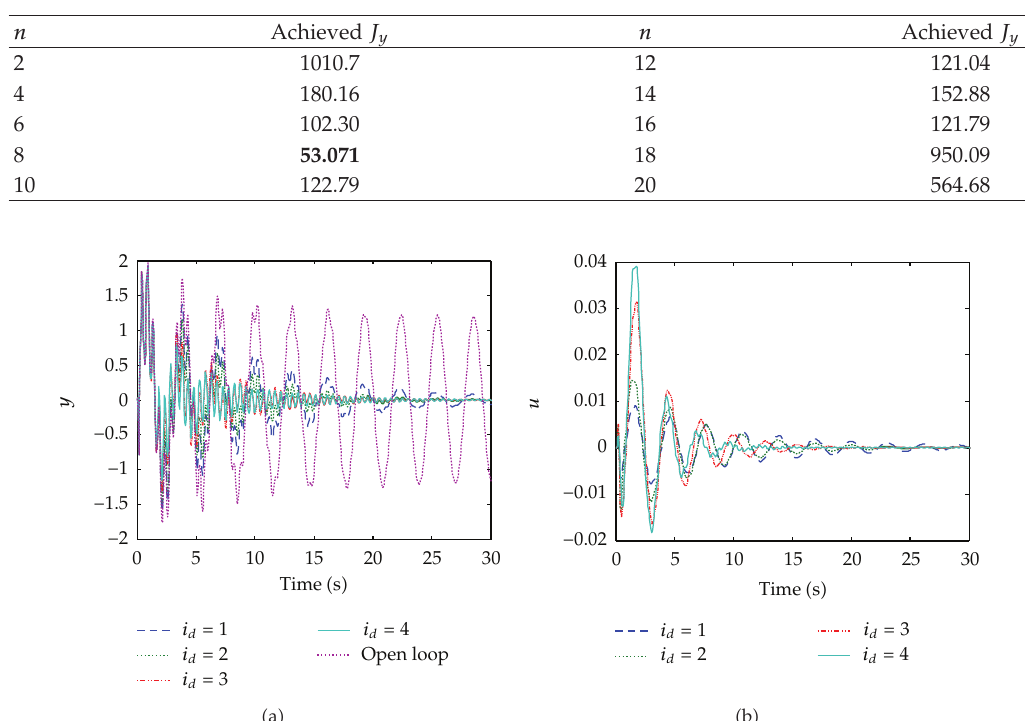
Figure 5: Impulse responses of the open and closed-loop systems (cid:4) n (cid:7) 8 (cid:5)